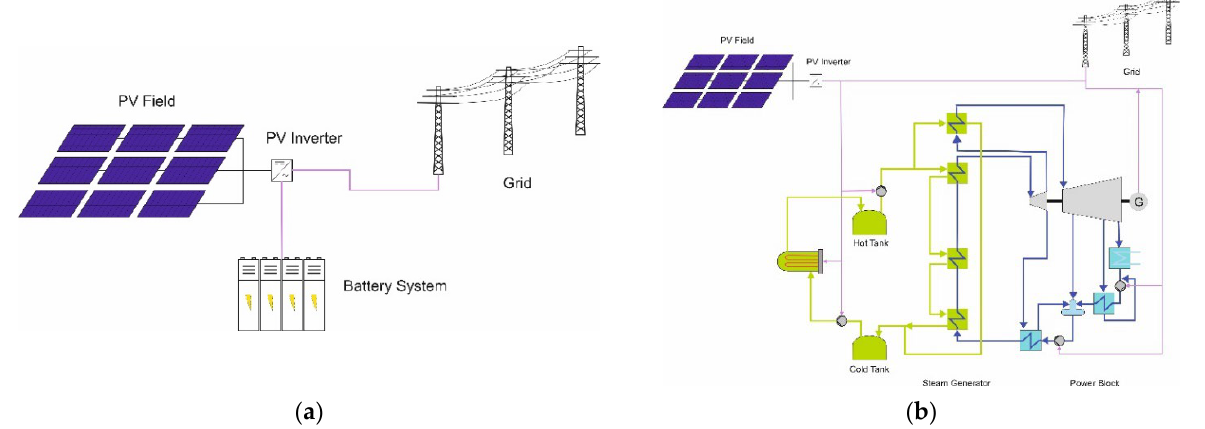
Figure 3. PV systems: ( a ) Photovoltaic system with a battery energy storage system (PV-BESS); ( b ) Photovoltaic system plus an electric resistance heater, thermal energy storage, and power block